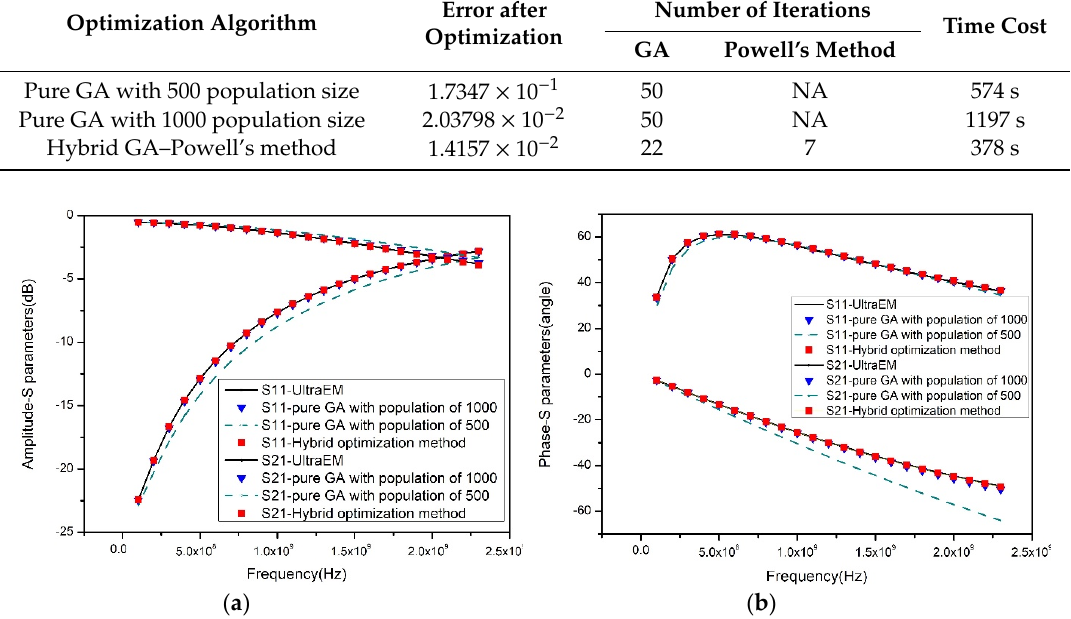
Figure 6. Comparison of S-parameters of the planar spiral inductor between UltraEM ® simulation and equivalent circuit simulation modeled by pure GA with population of 500, pure GA with population of 1000 and hybrid GA–Powell’s method. ( a ) Amplitude comparison of S-parameters. ( b ) Phase comparison of S-parameters. Table 3. Result of planar spiral inductor parameters extraction.